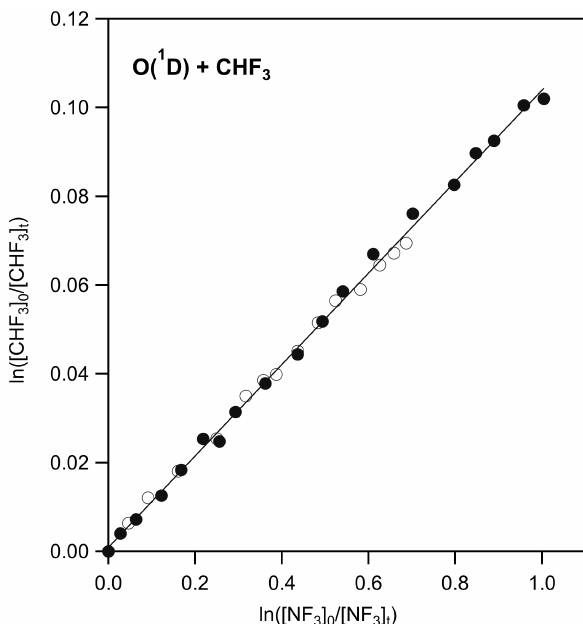
Fig. 3. Reactive rate coefficient data for the O( 1 D) + CHF 3 reac- tion with NF 3 as the reference compound obtained in two indepen- dent experiments (solid and open symbols). Experiments were per- formed at 296K with total pressures in the range 200 to 400 Torr (He). The uncertainty in the individual data points was estimated to be ± 1% of the initial reactant concentration and are not included for improved clarity. The line is a linear least-squares fit to the com- bined dataset. The obtained rate coefficient is given in Table 2.